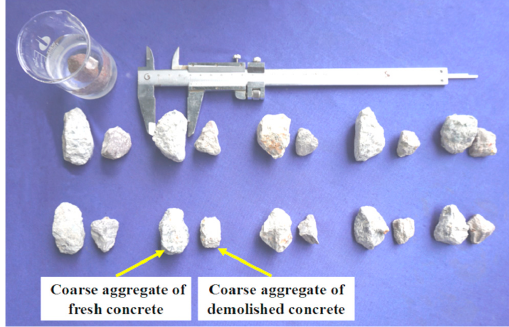
Figure 2. Maximum aggregate sizes for fresh concrete and demolished concrete.